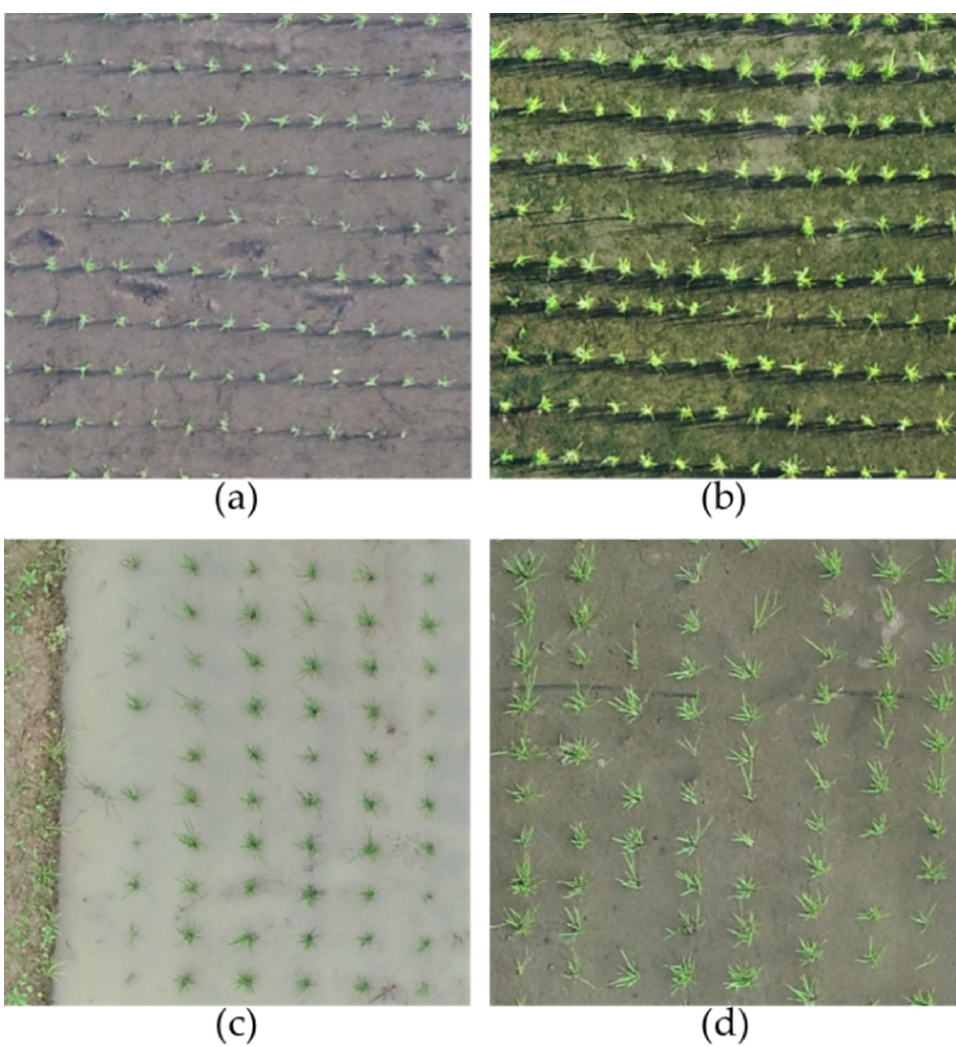
Figure 17. An example of the test images on four datasets on ( a ) 7 August 2018, ( b ) 14 August 2018, ( c ) 12 August 2019 and ( d ) 20 August 2019.